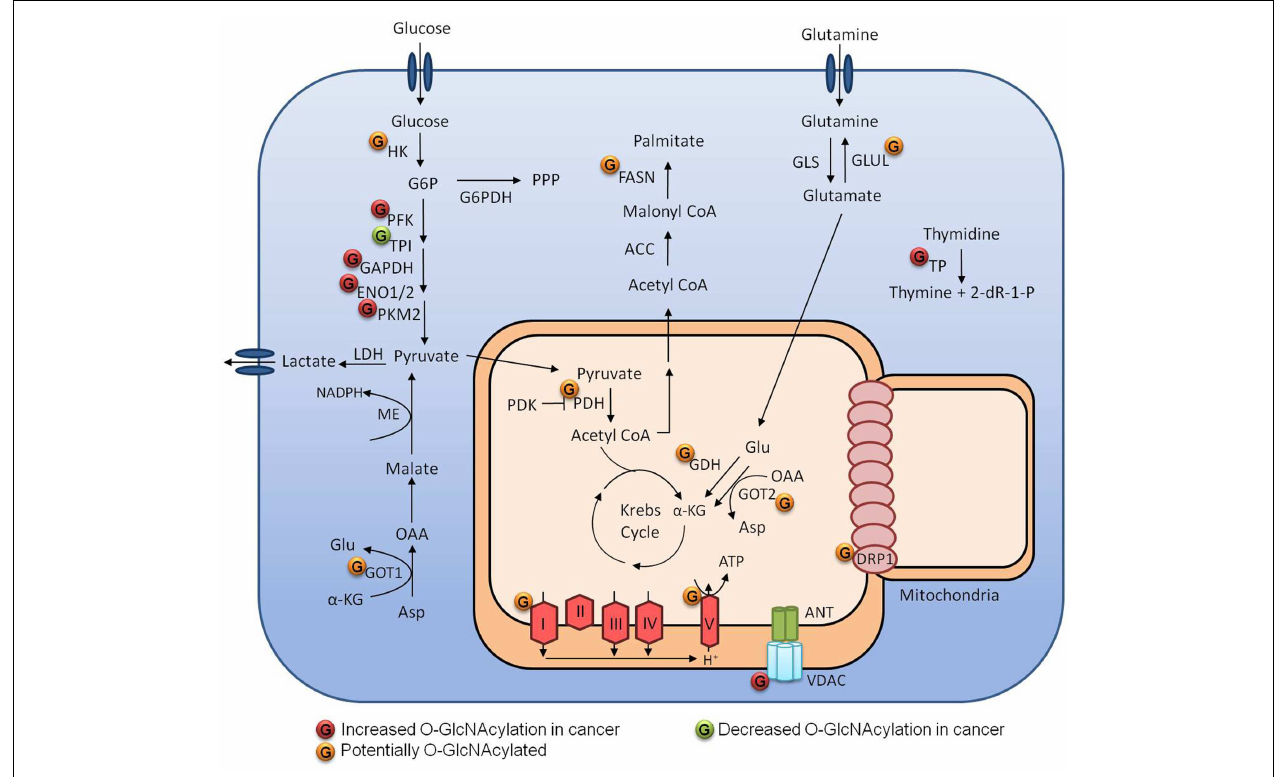
FIGURE 3 | Metabolism regulation by O-GlcNAcylation in tumor cells